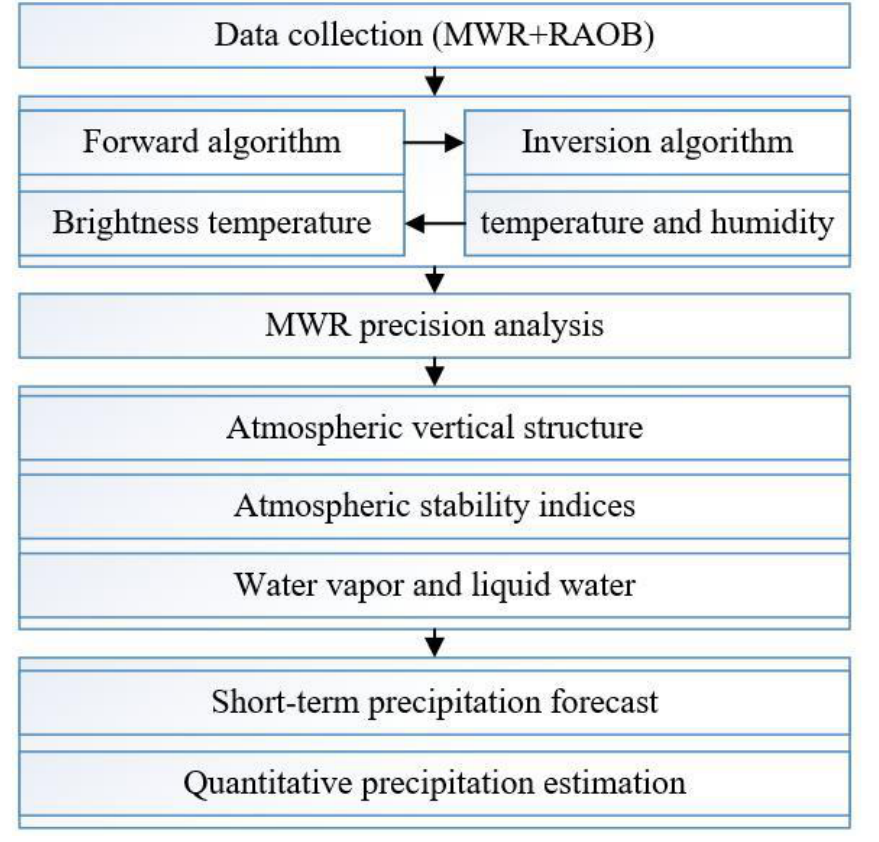
Figure 3. The framework of the article.